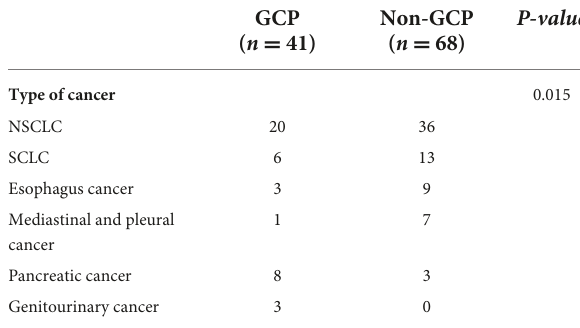
TABLE 1 Characteristics of patients in or not in clinical trials and their FCs (GCP or